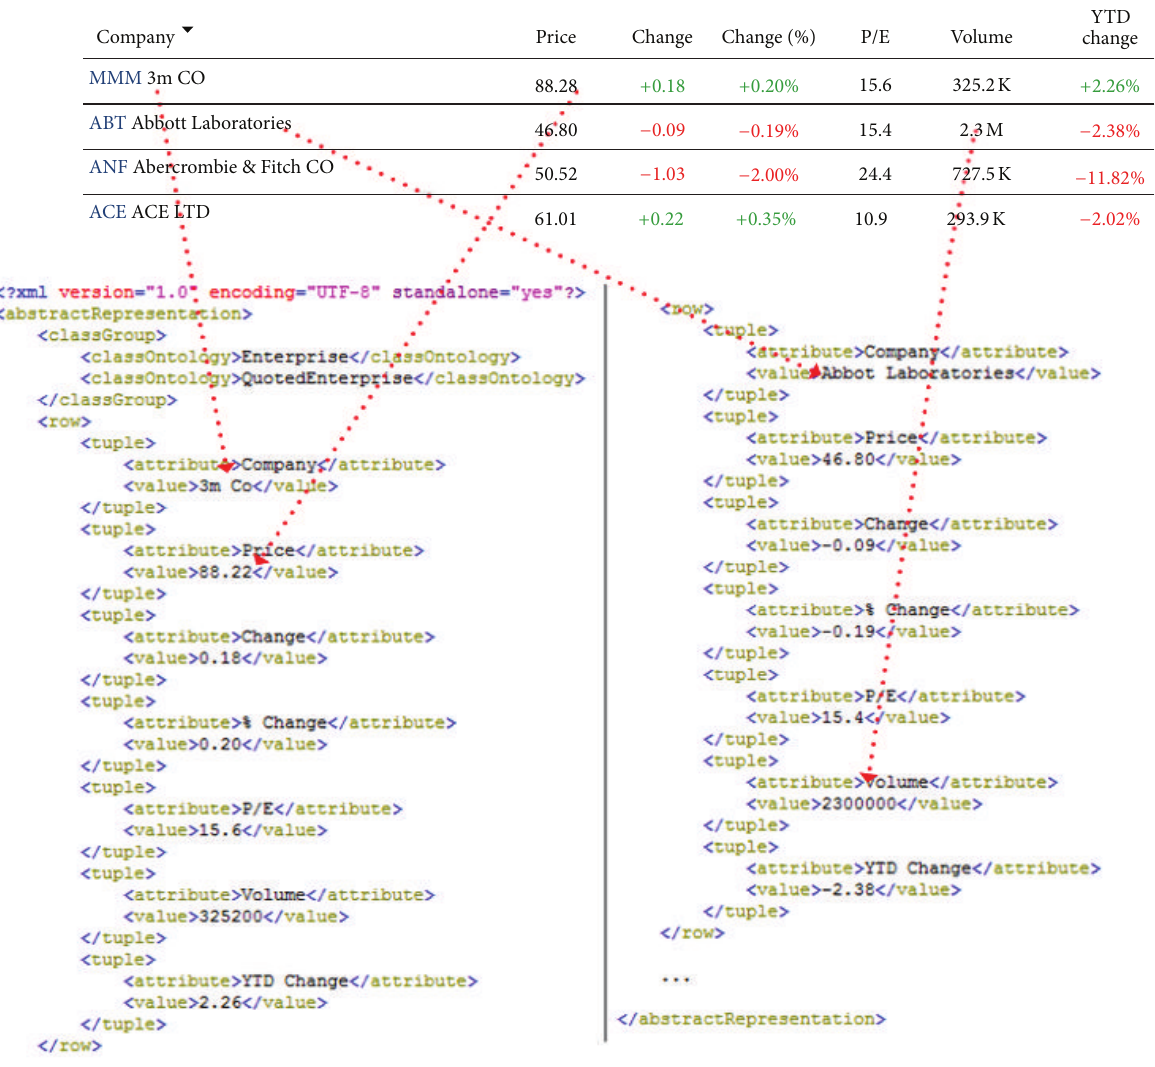
Figure 5: Mapping between a table and its corresponding XML file.